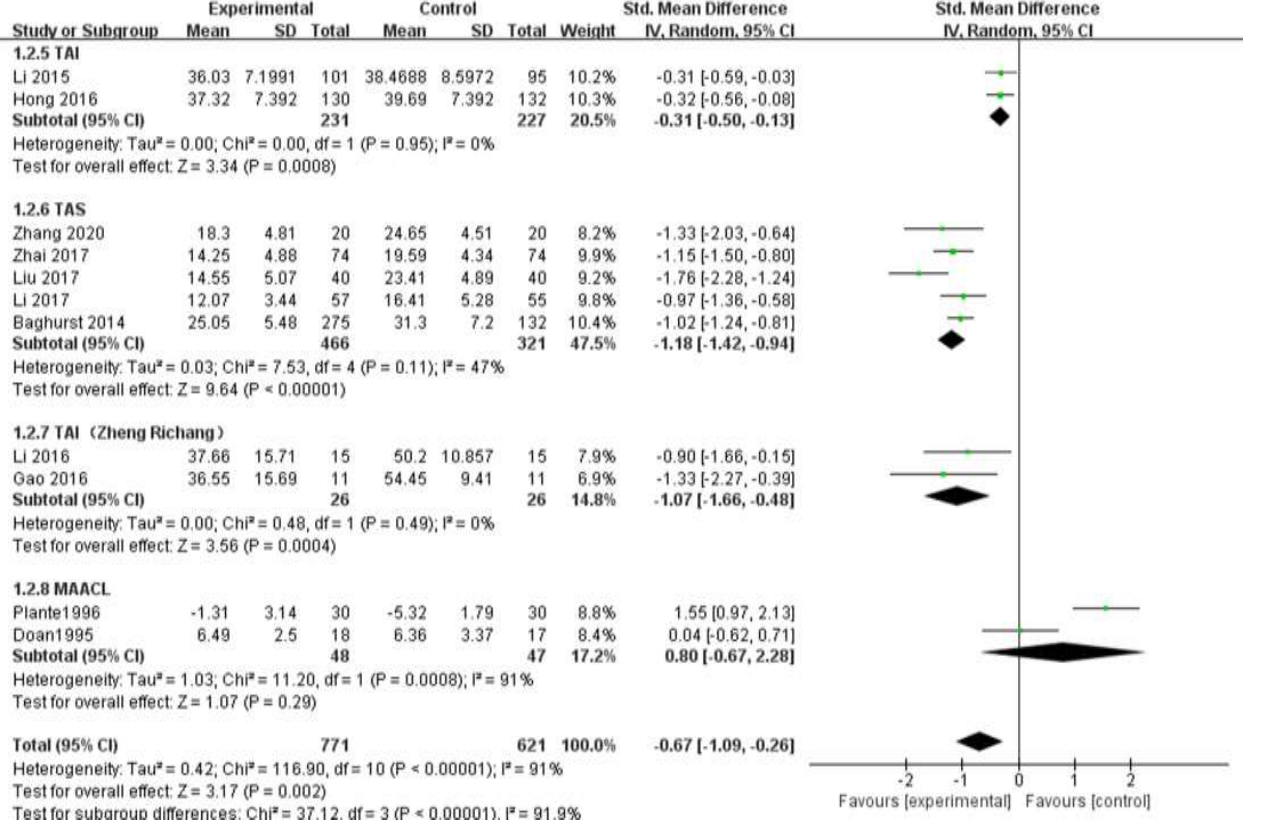
Figure 5. Subgroup analysis of outcome measurement scale [18–20,22–24,27–31].